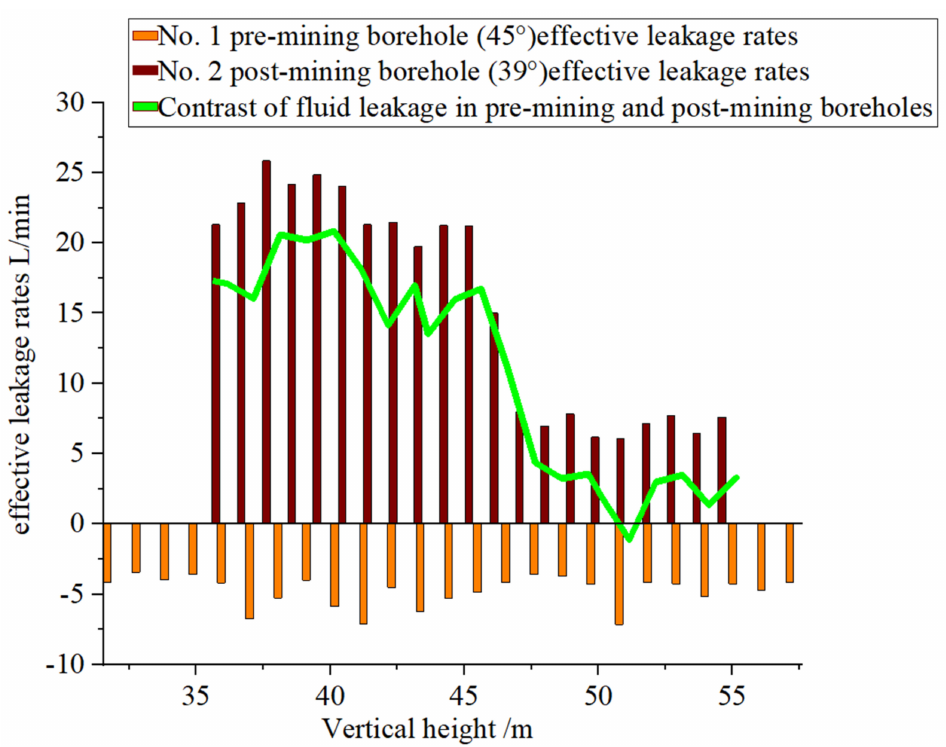
Figure 6. Contrast of fluid leakage in pre − mining and post − mining boreholes.